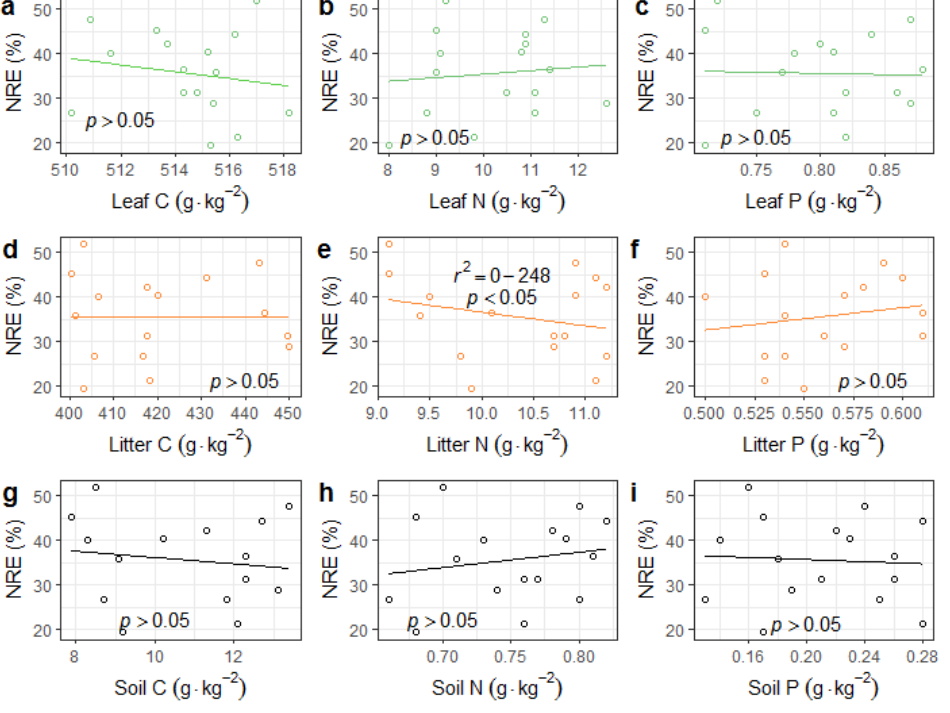
Figure A1. Relationships between NRE (N resorption efficiency)and leaf ( a – c ), litter ( d – f ), and soil ( g – i ) C, N, and P